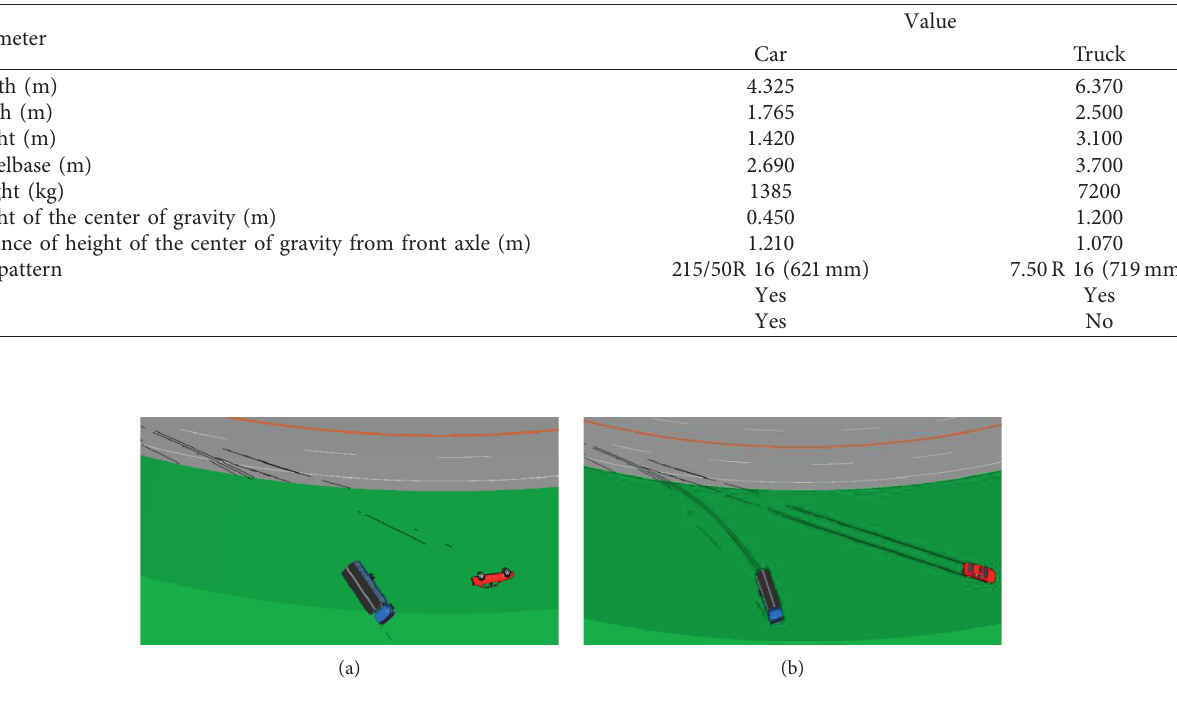
Table 4: Vehicle parameters.